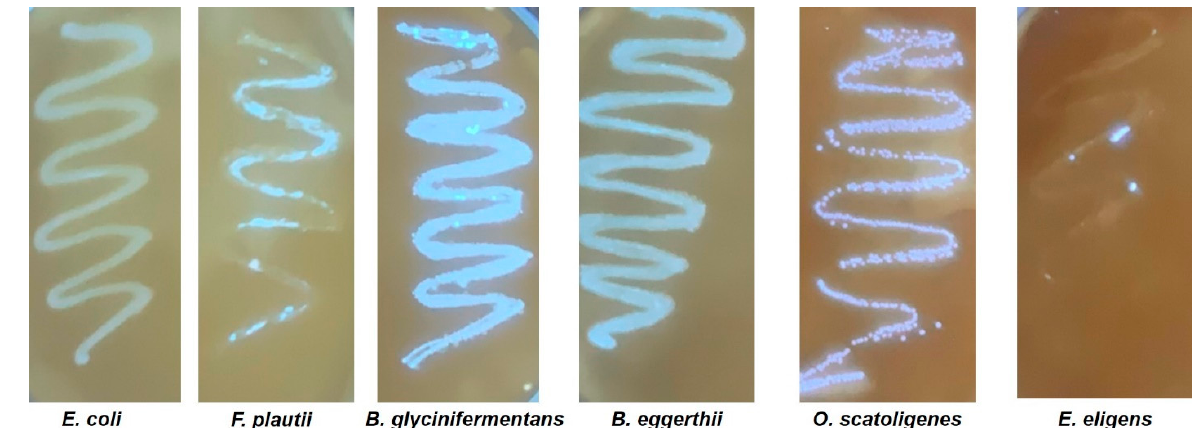
Figure 2. DPH assay demonstrating the ability of five bacterial species to biotransform quercetin. The figure shows bacterial growth on a nylon membrane soaked in a mixture of 1 mM DPH and 20 mM quercetin in mBHI agar plates. All the five quercetin-biotransforming bacterial species presented fluorescence, although to different degrees. However, the negative control, E. coli (non-quercetin-degrading bacteria), did not result in any fluorescence in this assay.